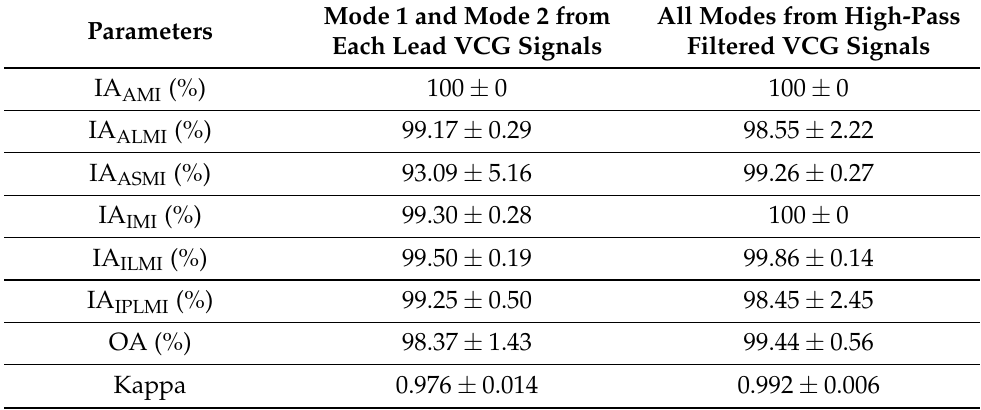
Table 10. Classification results obtained for MI localization using proposed MMDCNN model with mode